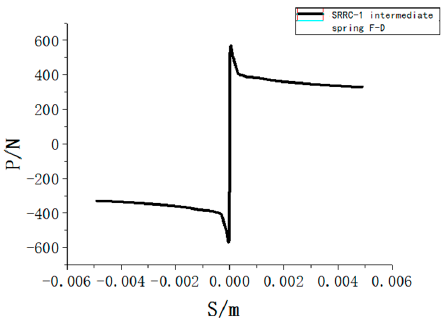
Figure 12. Schematic diagram of the force area calculation for the spring element.